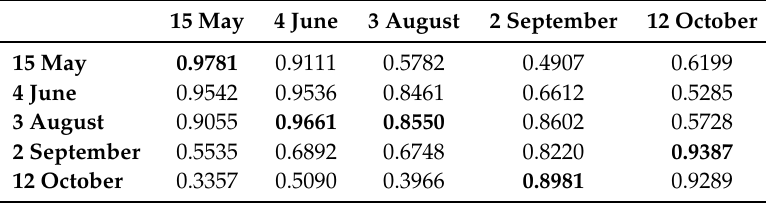
Table 7. Temporal transfer learning results for model “Optical-SAR+”. The ( i , j ) table entry corresponds to the accuracy ( ρ ) obtained on the j -th date (column) when training is carried out on the i -th date (row). 15